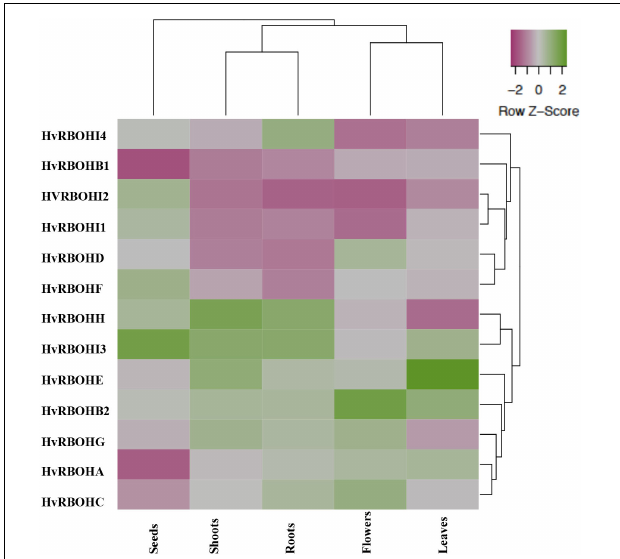
FIGURE 5 | Expression of the HvRBOH genes in different barley tissues. The relative expression of each HvRBOH gene was used for plotting the heat map. Average linkage clustering using Euclidean distances was used for clustering the HvRBOH genes and tissues. Green shade represents relative expression values greater than the median and pink shades represent expression values lower than the median across each